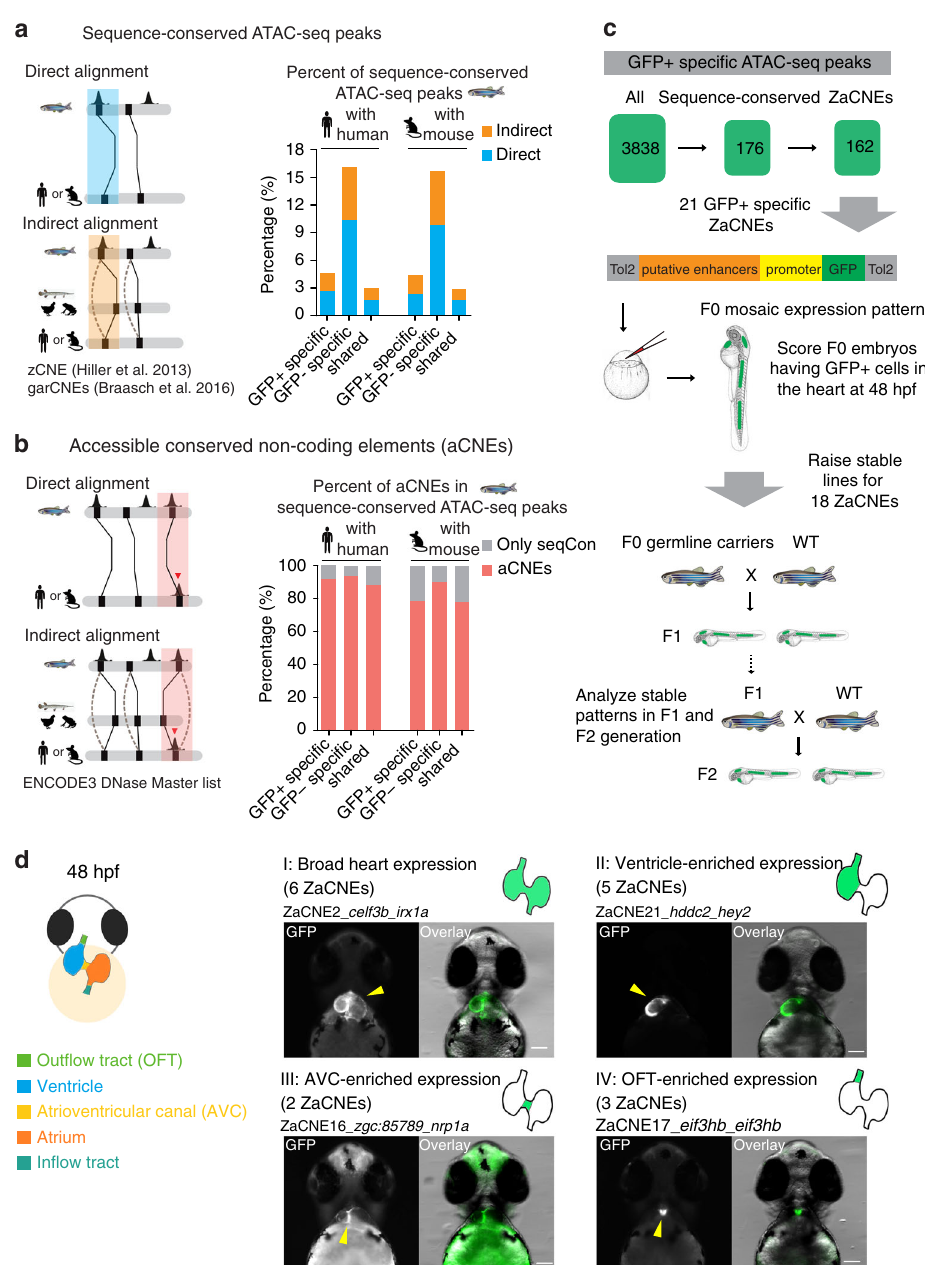
Fig. 3 Identi fi cation and in vivo characterization of accessible conserved non-coding elements (aCNEs). a Barplot showing the percentage of conserved regions in all GFP + / − speci fi c and shared ATAC-seq categories. Solid lines in the cartoon indicate direct sequence alignment and dotted lines showcases of indirect alignment bridged by intermediate species or ancestry reconstruction. b Barplot showing the aCNEs/sequenced conserved (seqCon) percentage. Most seqCon open chromatin regions were identi fi ed as having shared orthologous accessible chromatin. c Strategy for identifying and characterizing GFP + speci fi c aCNEs in zebra fi sh. Stable transgenic lines for 18 aCNEs were characterized. d Cartoon showing the zebra fi sh heart anatomy at 48 hpf (left panel). Heart expression patterns observed in ZaCNEs transgenic lines were classi fi ed into 4 categories (right panel), including I: broad expression in the whole heart; II: ventricle-enriched expression; III: atrioventricular (AVC)-enriched expression; IV: out fl ow tract (OFT)-enriched expression. One representative example of each category was shown and the numbers of ZaCNEs fall in each category are indicated in the brackets. The two closest genes near each ZaCNEs are indicated. All images were taken from the ventral view and all scale bars represent 100 μ